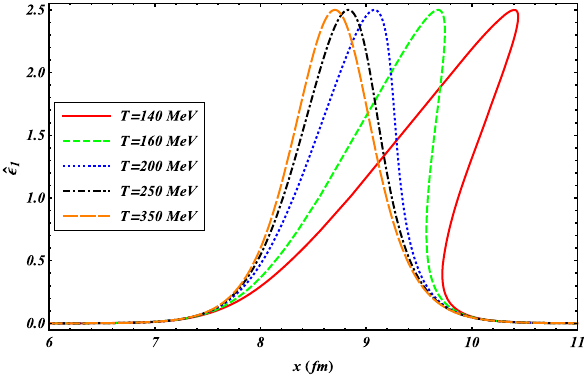
Fig. 5 Solutions at t = 15 f m fordifferent Tsallistemperaturevalues. A = 2 . 5, B = 0 . 5 f m , and q = 1 . 08